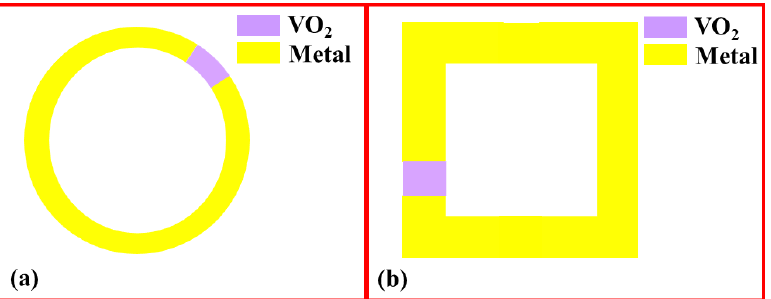
Figure 11. Metamaterial polarization converters based on ( a ) circular split ring resonator structure; ( b ) square split ring resonator structure.